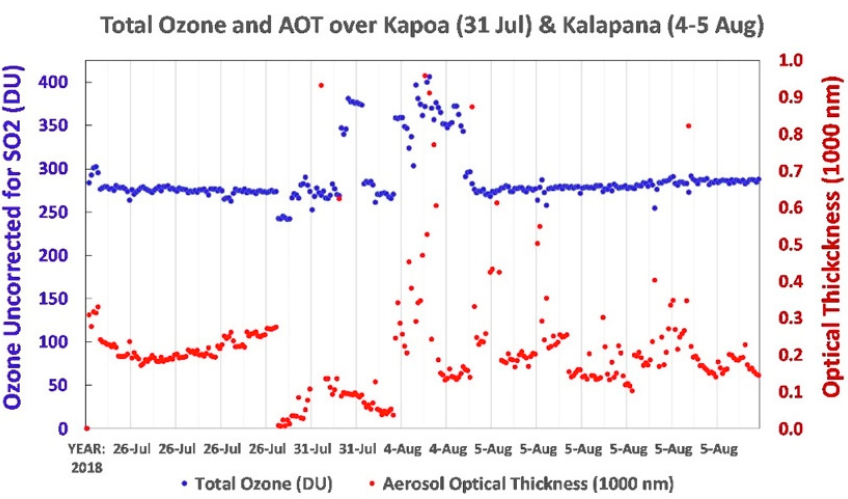
Figure 11. Microtops II indicated normal total ozone amounts outside the SO 2 -laden plume from Fissure 8 and highly inflated total ozone through openings in the plume.